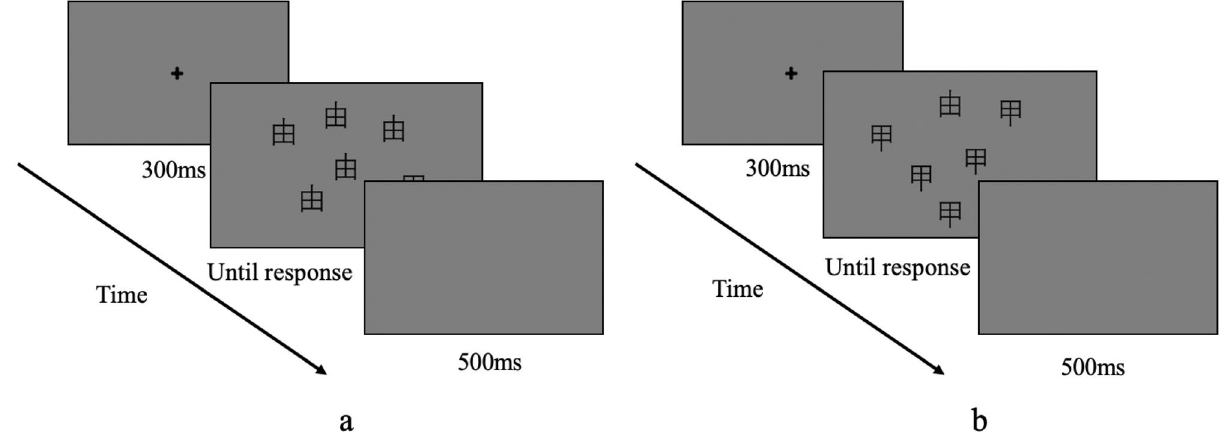
Figure 2. Timeline showing the process for a single visual search trial in Experiment 1. ( a ) Searching for “ 甲 ” from “ 由 ”. ( b ) Searching for “ 由 ” from “ 甲